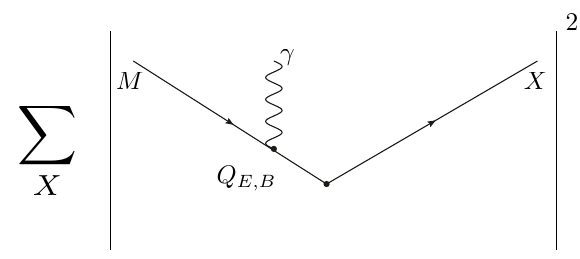
Figure 5 . The diagram responsible for inclusive photon production induced by the de(cid:13)ection of a black hole due to the interactions with an external current. The soft emission factorizes from the hard scattering o(cid:11) of the